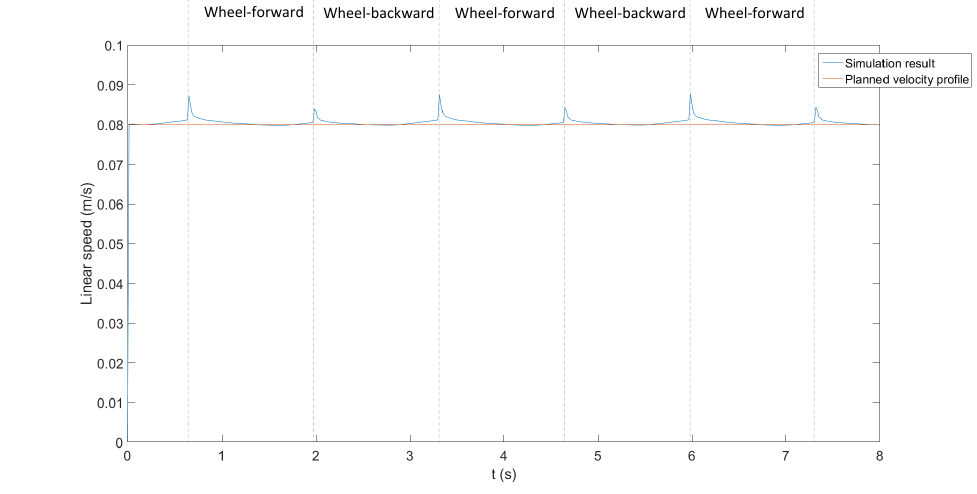
Figure 7. Ideal and real angular velocities of the walking joints and wheels. As shown, the walking joint generates a peak for each step. It is due to the joint controller implemented in Vortex Studio. The wheel is able to follow the velocity reference with a small time delay.